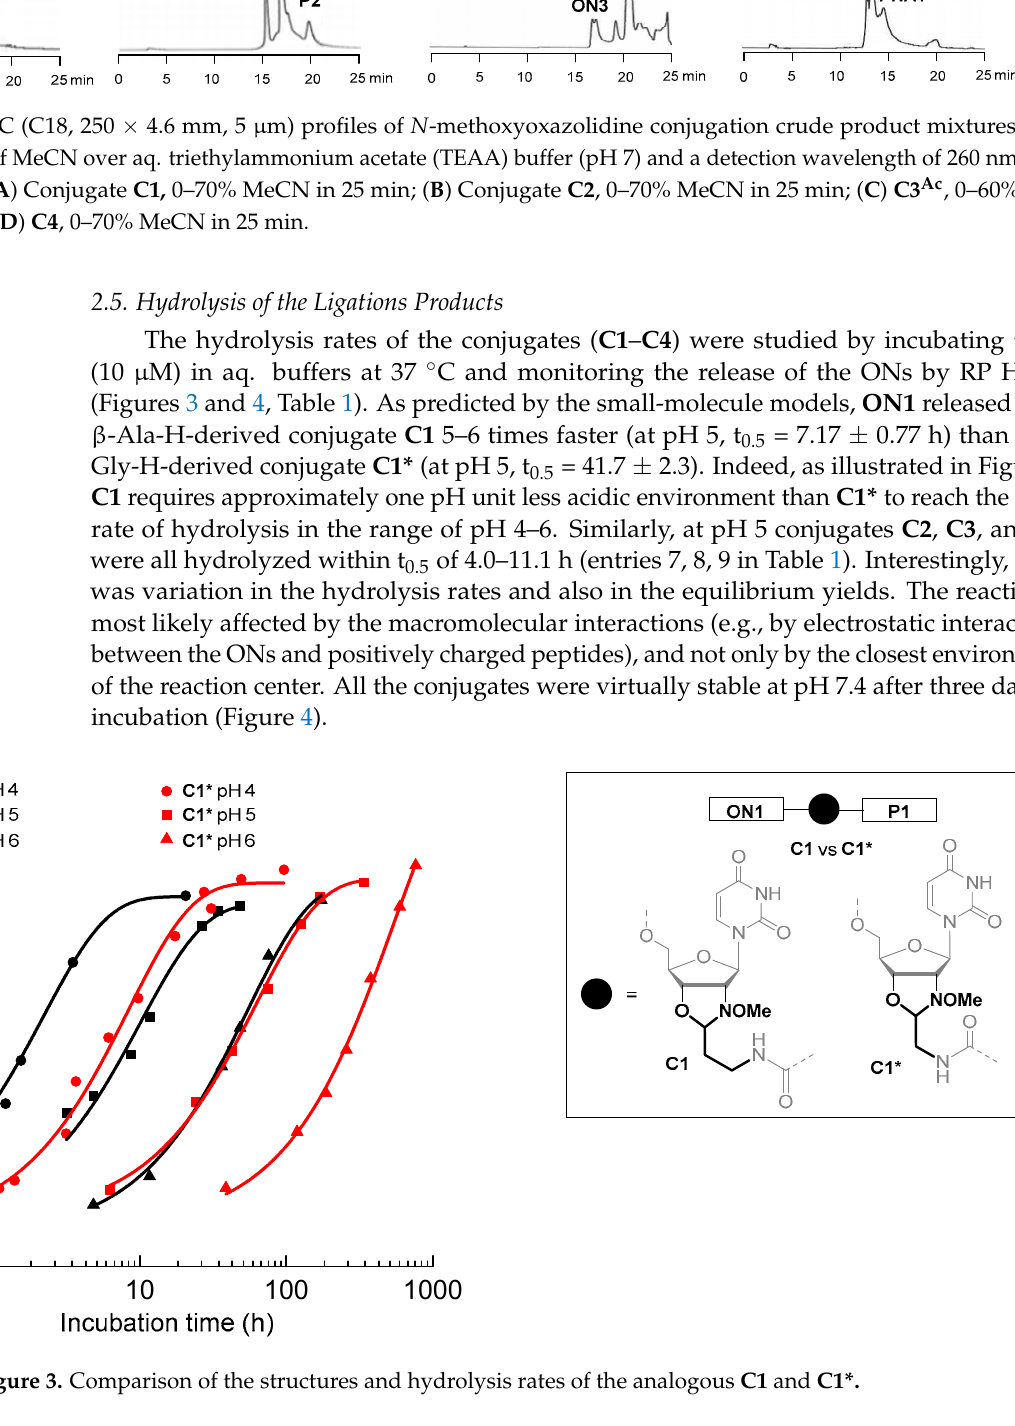
Figure 2. RP HPLC (C18, 250 × 4.6 mm, 5 µ m) profiles of N -methoxyoxazolidine conjugation crude product mixtures. Figure 2 . RP HPLC (C18, 250 × 4.6 mm, 5 µm) profiles of N -methoxyoxazolidine conjugation crude product mixtures. A linear gradient of MeCN over aq. triethylammonium acetate (TEAA) buffer